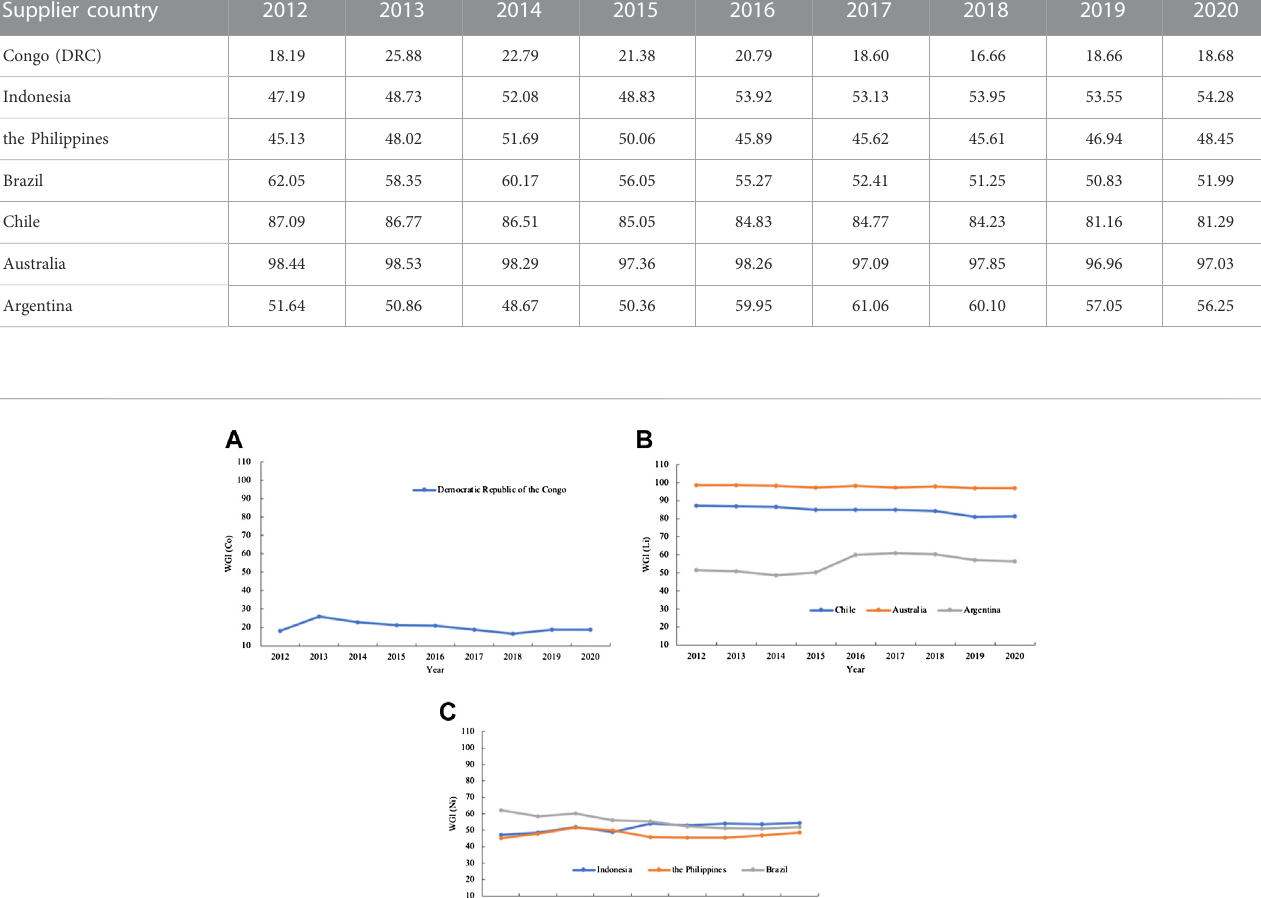
TABLE 3 National governance index of importing countries of lithium, cobalt, and nickel imports. Supplier country